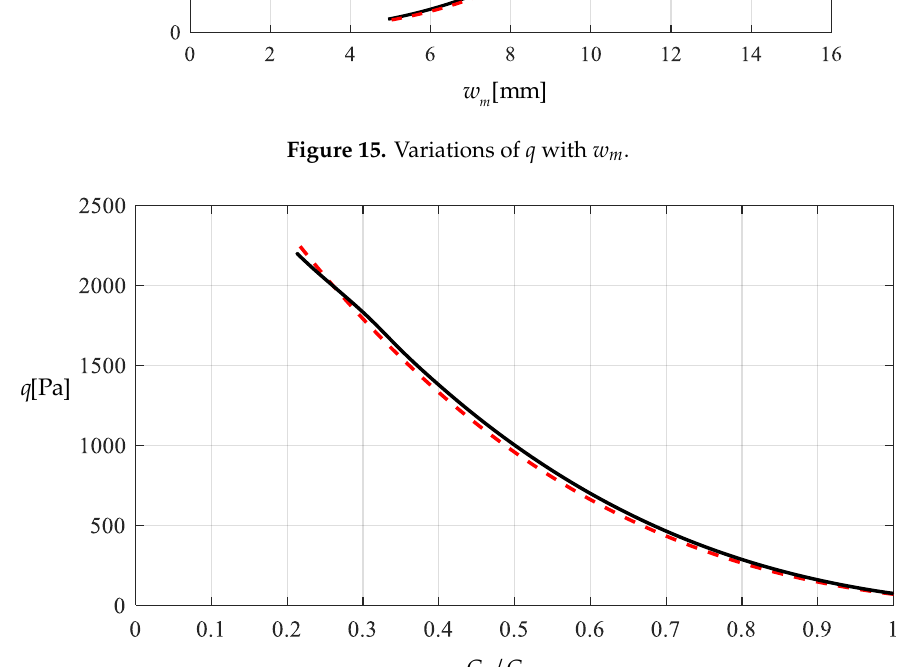
Figure 16. Variations of q with C 0 / C .